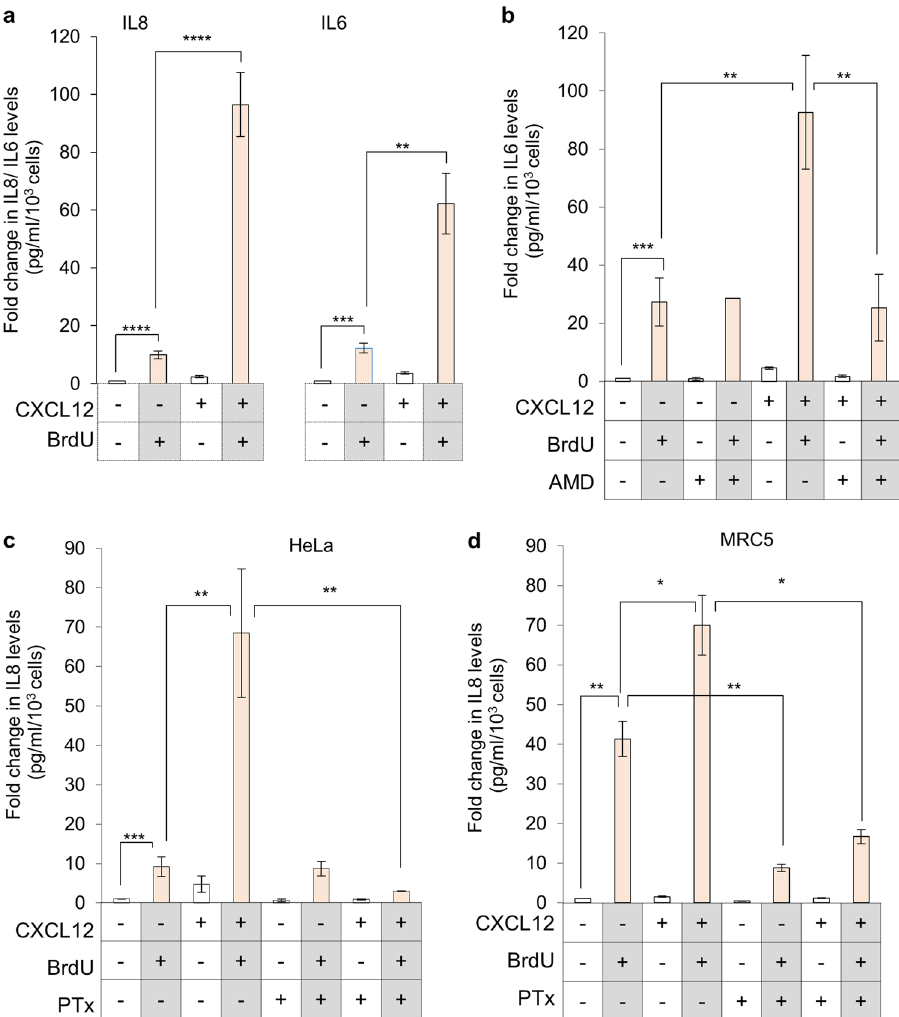
Fig. 4 CXCR4 receptor regulates DNA-damage associated in fl ammation. For all experiments, media from treated cells (as indicated), was used for sandwich ELISA for determining levels of IL8 or IL6 pg/ml secreted per 10 3 cells, represented as fold change over control untreated cells. a Effect of activation of CXCR4-CXCL12 signaling during DNA damage on IL8 and IL6 cytokine secretion ( n > 6). b Effect of CXCR4 inhibition (AMD treatment) on IL6 production from senescent cells post-CXCL12 stimulation. Cells were treated with various compounds as indicated and IL6 levels in supernatant were analysed ( n = 3). c Effect of inhibition of G α i by PTx treatment. Comparison of IL8 levels between HeLa cells treated with BrdU; BrdU + CXCL12 or BrdU + CXCL12 in presence of pertussis toxin (PTx) ( n = 3). d Effect of inhibition of G α i by PTx treatment on MRC5 cells. Comparison of IL8 levels in MRC5, primary cells treated with BrdU; BrdU + CXCL12 and BrdU + CXCL12 in presence of PTx ( n = 3). For all experiments, results are represented as mean ± s.e.m. * p ≤ 0.05, ** p ≤ 0.01, *** p ≤ 0.001, **** p ≤ 0.001 (Student ’ s t